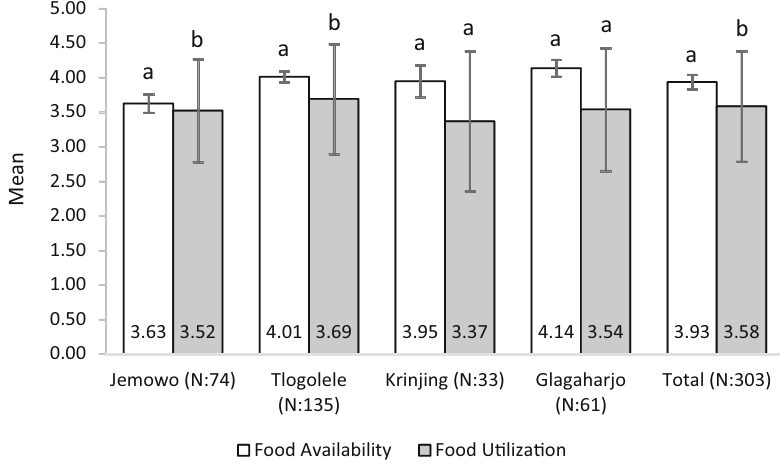
Figure 4: Mean value and standard deviation of total food availability and food utilization. Mean values ± standard deviation with di ff erent letters are signi fi cantly di ff erent ( p < 0.05 ) .